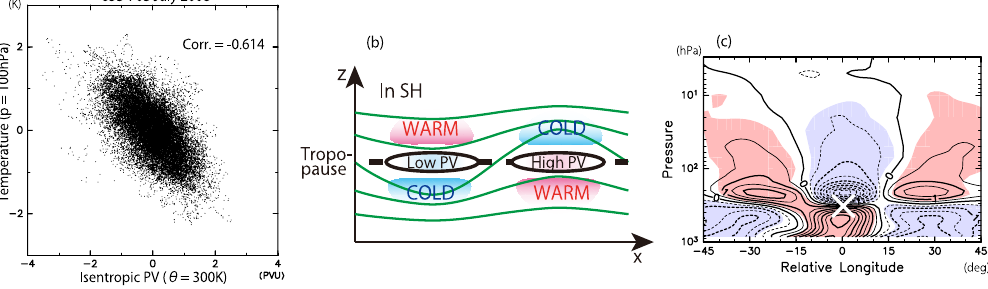
Fig. 6. (a) A scatter diagram of s = 4–20 potential vorticity fluctuation components on 300K isentropic surface and s = 4–20 temperature fluctuation components at 100hPa in the latitude range of 65 ◦ S–70 ◦ S in July. “Corr.” stands for correlation coefficient. (b) A schematic illustration of the relation between temperature anomalies (colors) and potential vorticity near the tropopause (black broken line) in the Southern Hemisphere. Green curves indicate isobars. (c) A composite of the relative longitude-pressure section of s = 4–20 temperature components in July 2008 with a reference point (a white cross mark) where the s = 4–20 potential vorticity components are positive and maximized in the zonal direction at 65 ◦ S on θ =300K surface, and values are larger than 2.5PVU. Contour intervals are 0.5K. Broken contours indicate negative values. Shading shows the regions with significance levels greater than